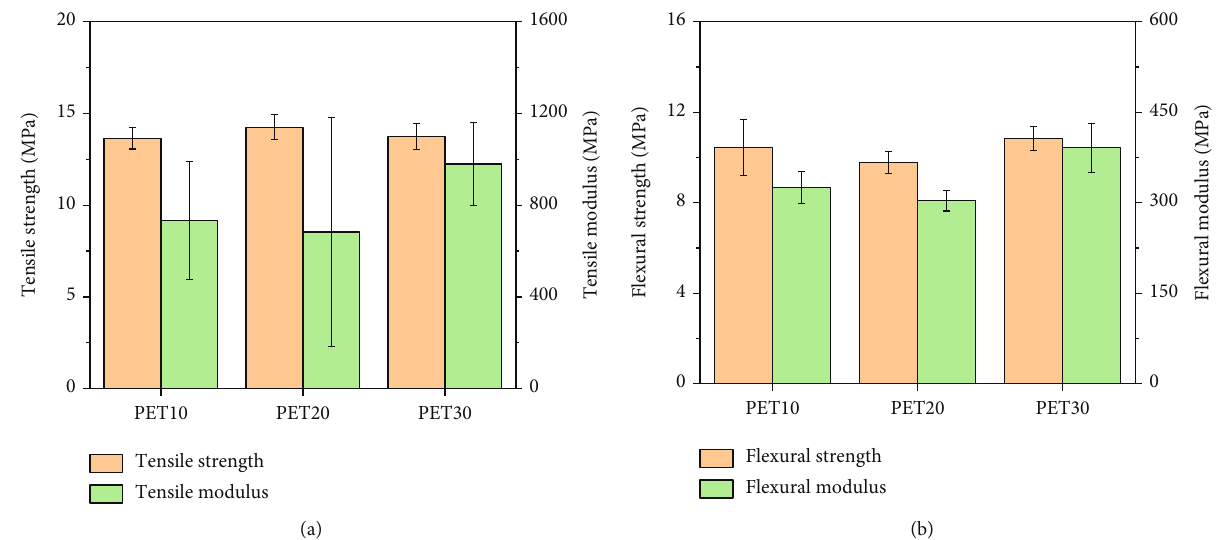
Figure 2: (a) Tensile strengths and tensile modulus of 3D-printed PP strengths and fl exural modulus at di ff erent blending temperatures.